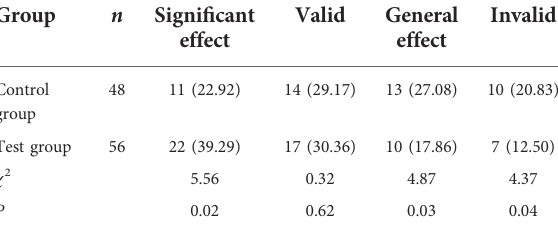
TABLE 3 Comparison of curative effect of two groups of patients at 1 year after operation [ n (%)]. Group